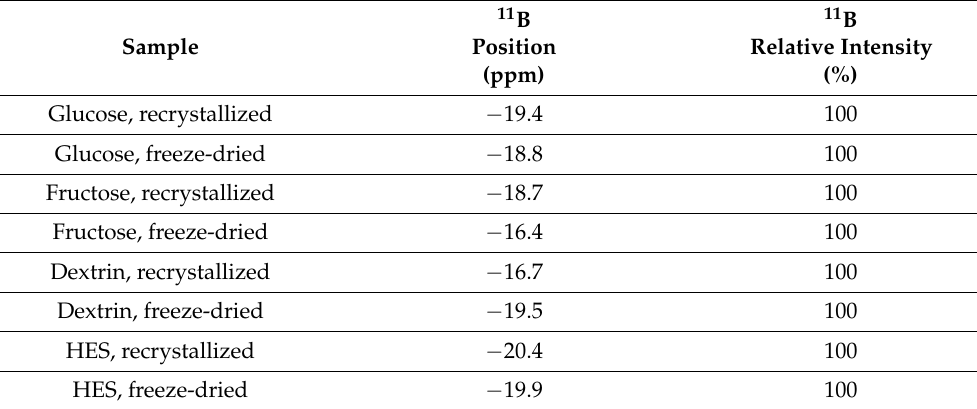
Table 2. The parameters of lines on the 11 B MAS NMR spectra of different saccharide precursors mixed with boric acid.